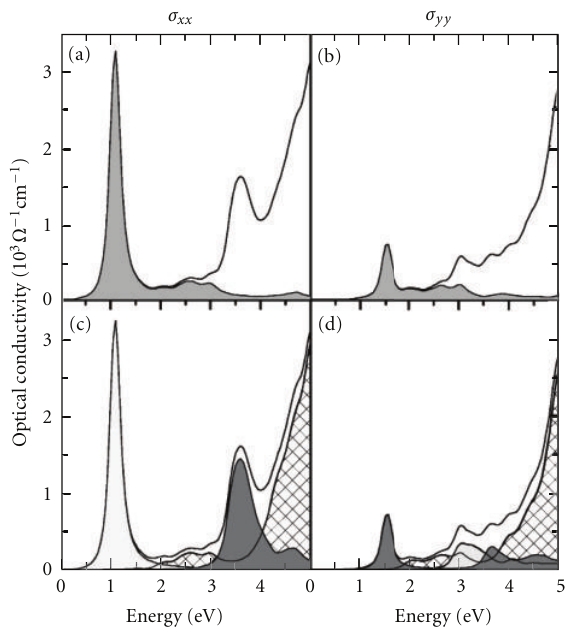
Figure 35: Decomposition of the optical conductivity σ xx ((a) and (c)) and σ yy ((b) and (d)) into the contribution from the transitions corresponding to di ff erent initial ((a) and (b)) and final states ((c) and (d)), calculated with U e ff = 3eV [249]. The total optical conductivity is shown by the white area, respectively. The grey area in (a) and (b) shows the contribution from the transition with the initial states given by the occupied V d xy bands. In (c) and (d) the transitions with the final states restricted to the antibonding V 3 d ↑ xy and the bonding V 3 d ↓ xy states are denoted by light grey and grey areas, respectively. The hatched area shows the contribution from interband transitions to higher-lying V 3 d